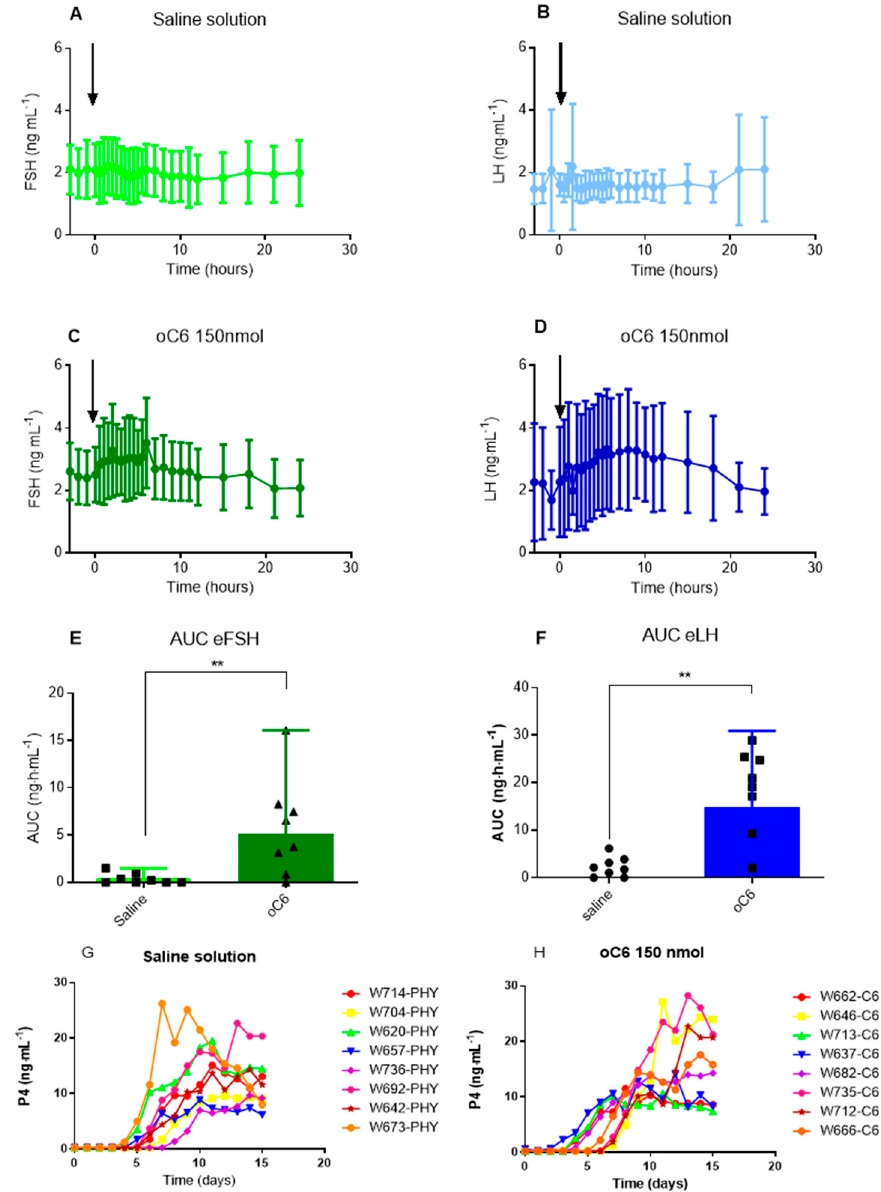
Figure 7. Effect of oC6 iv injection on gonadotropins and progesterone during the breeding season. During the breeding season, either oC6 (150 nmol/mare) or saline solution were injected at time zero (arrow). Serial blood samples were taken from 4 h before to 24 h after injection and assessed for FSH and LH content by ELISA and RIA, respectively ( A – D ). The injection of oC6 increased the total amount of FSH released compared to saline solution (( E ), U = 8, p = 0.01). The total amount of LH secreted during the 24 h after oC6 treatment increased by about 8-fold compared to saline solution (( F ), U = 4, p = 0.02). In ( G , H ) are shown the individual profiles of plasma progesterone (P4) concentration in the 15 days following the injection of saline solution ( G ) or oC6 ( H ). Data are expressed as mean ± SD ( A – D ) or median and interquartile range ( E , F ). Statistical analysis was performed by ANOVA on repeated measures ( A – D ) or Mann-Whitney test ( E , F ). ** p ≤ 0.02. The AUC analysis showed that oC6 increased FSH and LH secretion compared to saline solution by about 15- and 8-fold, respectively (Figure 7) (U = 8, p = 0.01, U = 8, and U = 4, p = 0.02,